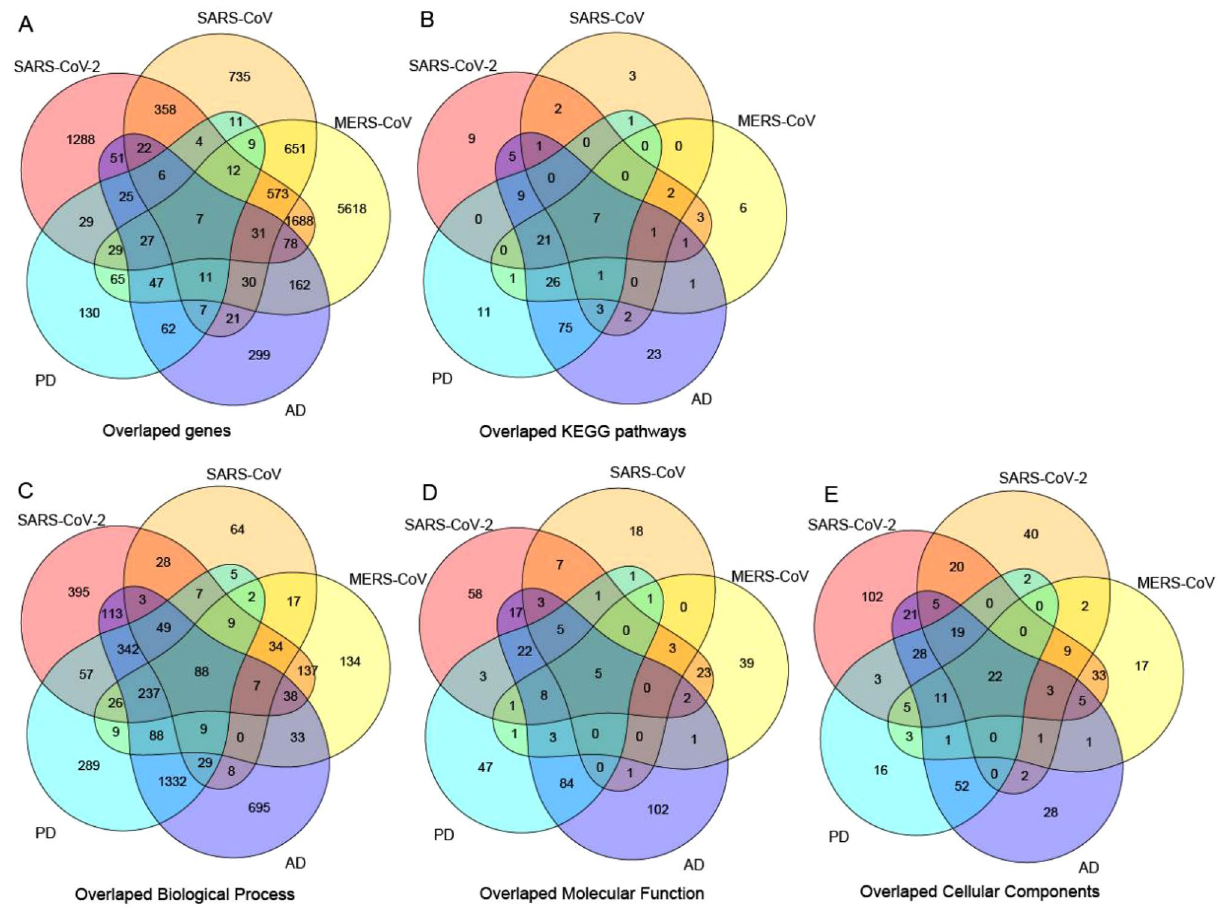
Figure 2. The common molecular signatures between three coronaviruses (SARS-CoV-2, SARS-CoV and MERS-CoV) and two neurodegenerative diseases (AD and PD). ( A ) The overlapped genes between VIGs and DGs; ( B – E ) The overlapped KEGG pathways ( B ) and GO terms in domains of Biological Process ( C ), Molecular Function ( D ) and Cellular Component ( E